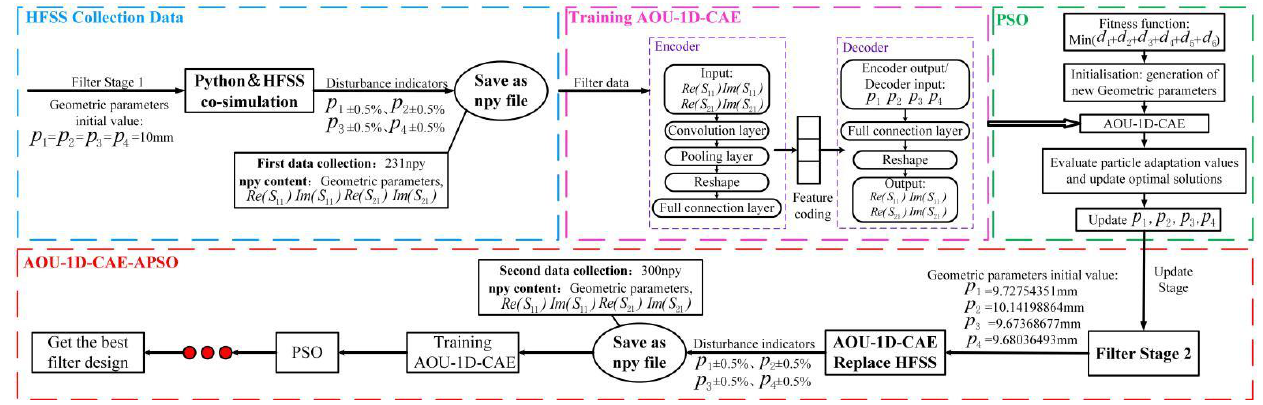
Figure 11. Details of the AOU-1D-CAE optimization.